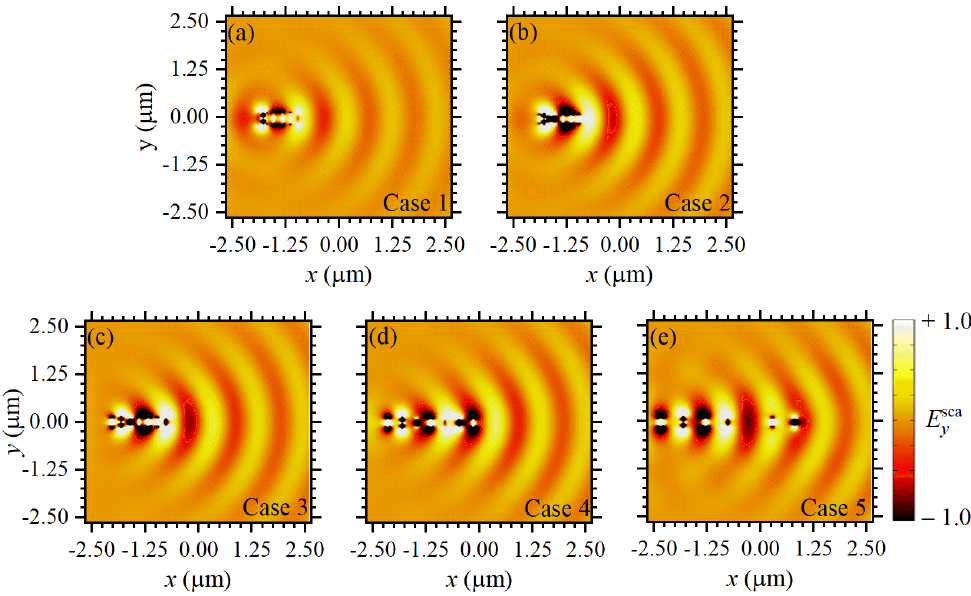
Figure 3. ( a – e ) The electromagnetic scattered fields (near-fields) for Cases 1 to 5, respectively. Table 1. Optimized geometric parameters for the five